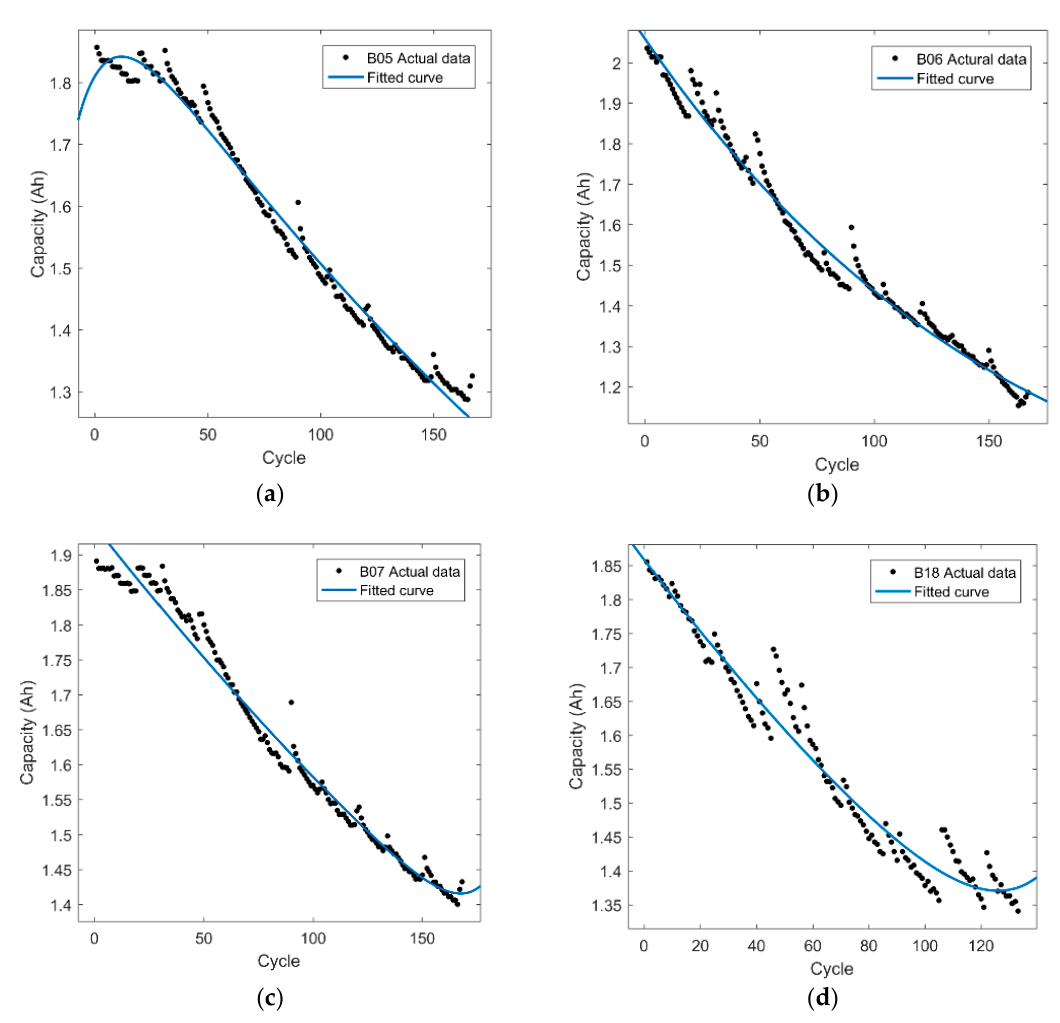
Figure 4. NASA Ames Research Center Prognostics Center of Excellence battery dataset.